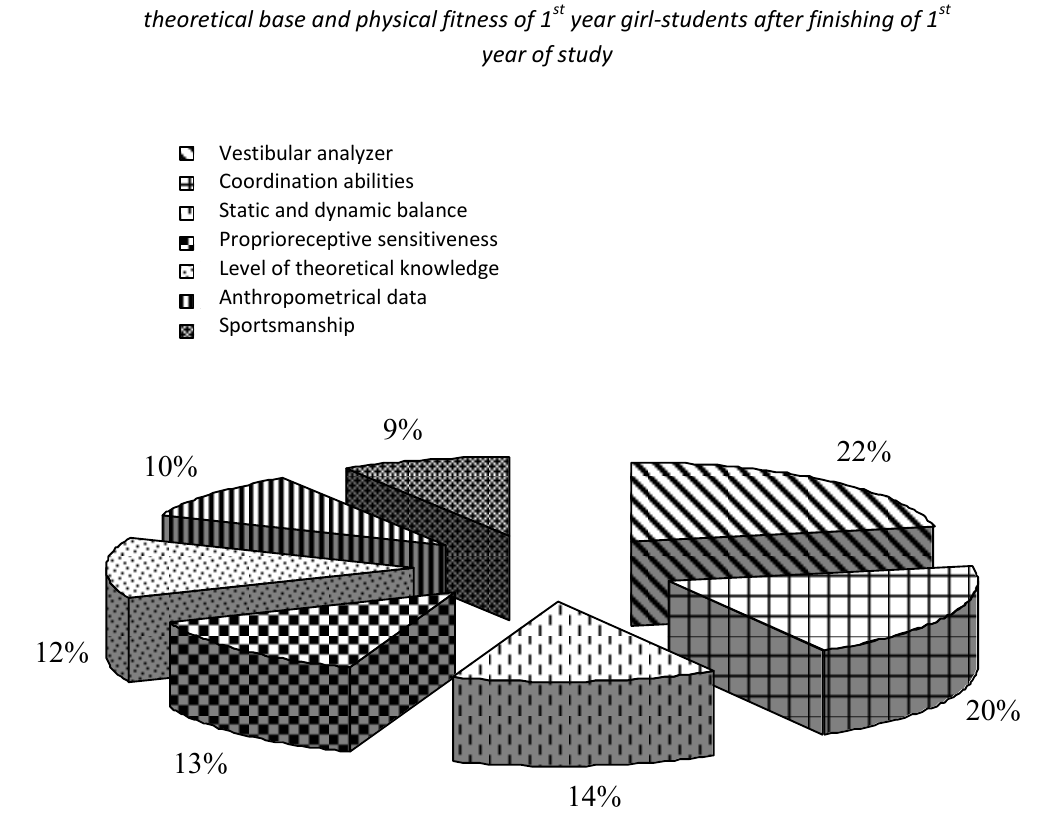
Fig.4 Correlation of factors, which determine level of sensorimotor coordination, theoretical base and physical fitness of 1 st year boyl-students after finishing